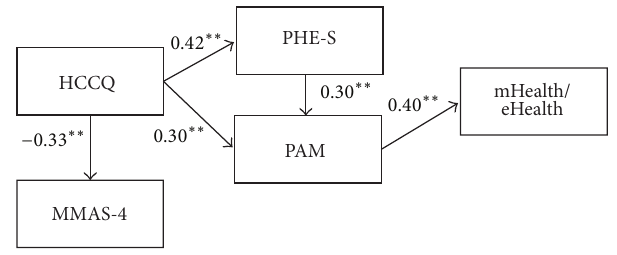
Figure 2: Structural Equation Model